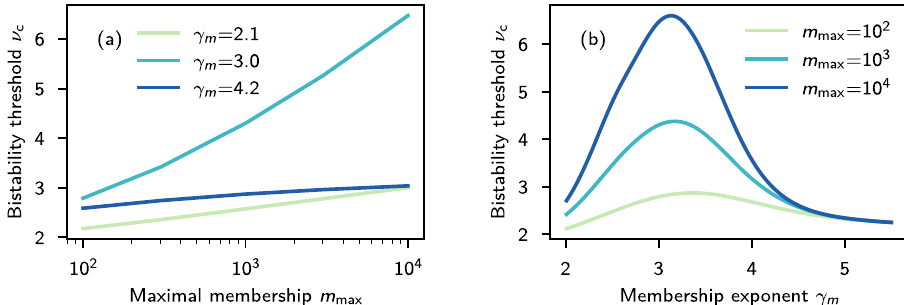
Fig. 6 Impact of heterogeneous memberships on the bistability threshold. We considered hypergraphs with power-law membership distributions g m (cid:5) m (cid:2) γ m with various exponents γ m , different maximal values m max , a minimal value m min ¼ 2, and a regular group size distribution p n = δ n ,4 . We obtain the bistability threshold by solving Eq. (21). Lower values of γ m imply a more heterogeneous membership distribution. a The bistability threshold grows logarithmically or faster for γ m ≤ 4 but converges for γ m > 4. b The bistability threshold shows a maximum near γ m = 3, suggesting that this is the maximum in the limit m ! max